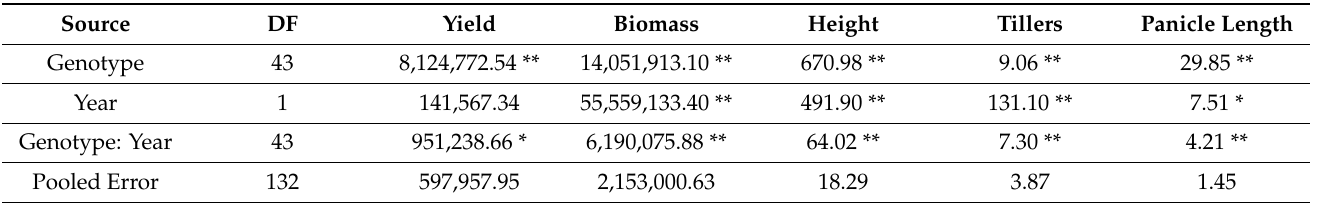
Table 1. Analysis of variance for yield, biomass, plant height, tillers, and panicle length of rice genotypes with the direct seeding